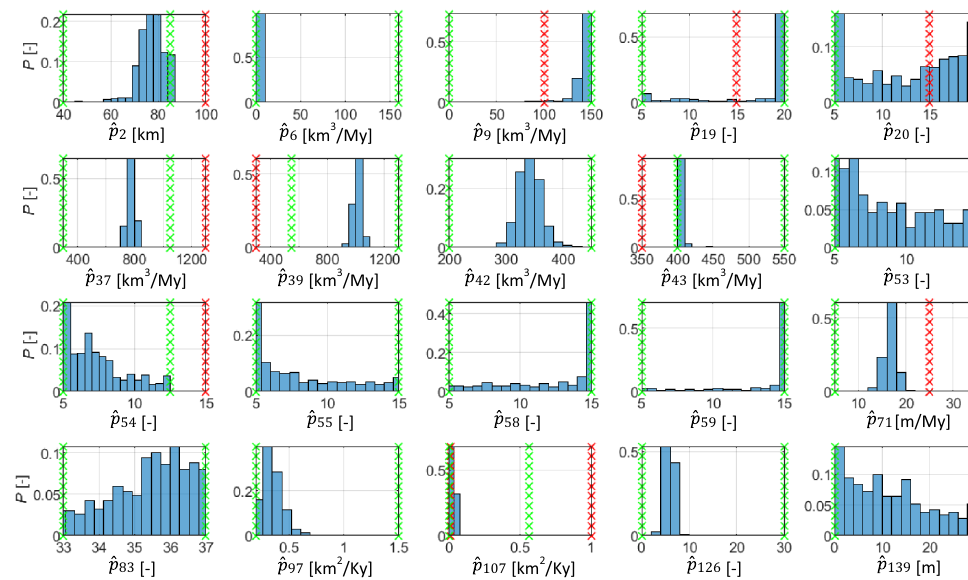
Figure 9. Histogram of the marginal probability distributions of input parameters obtained from the sample of 500 calibrations. Vertical red lines indicate the initial parameter range, green lines indicate the revised ranges obtained by following the procedure in Section "Range